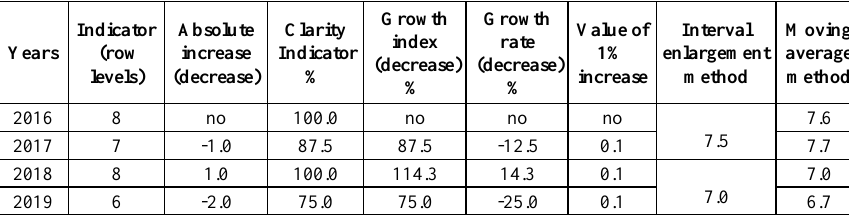
Table 6. Attendance dynamics in the experimental